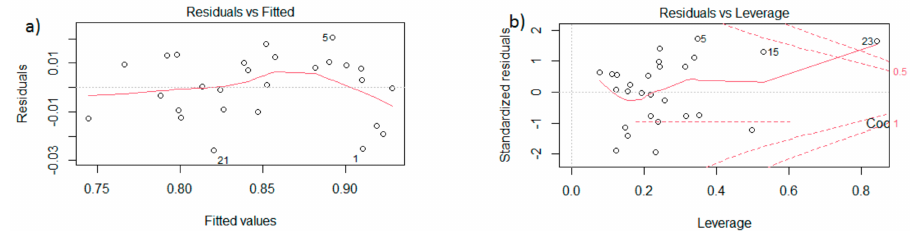
Figure 4. Residual characteristics of linear model (printout). Developed by